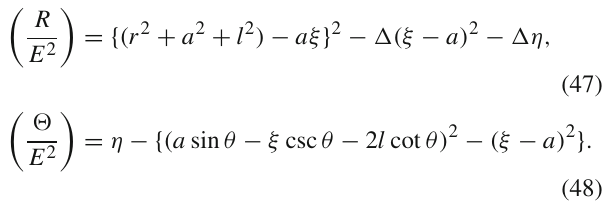
and P θ = d θ/ d ν , the following expressions for the radial and angular equations are obtained,